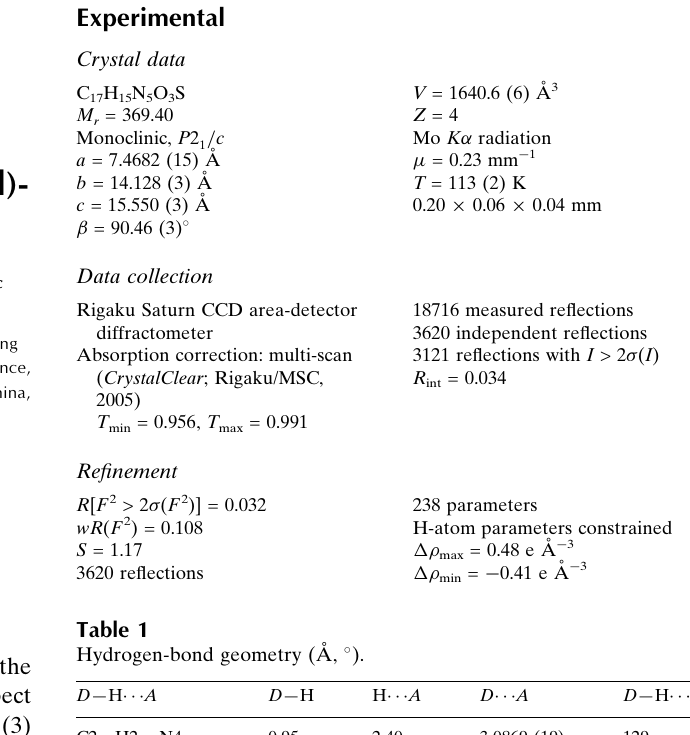
Rigaku Saturn CCD area-detector diffractometer